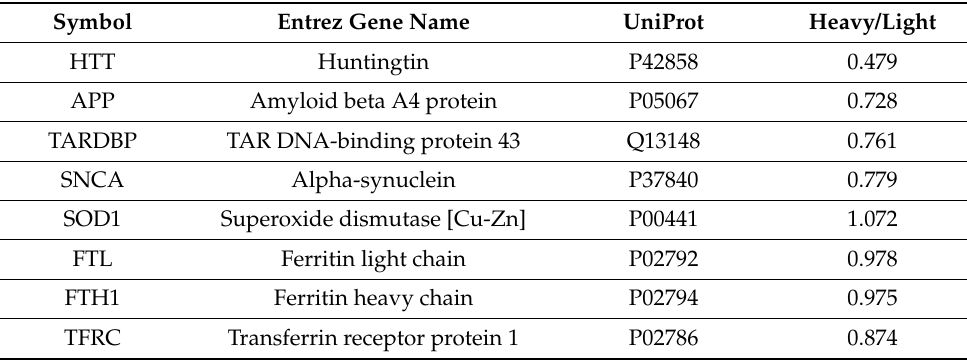
Figure 2. Functional bioinformatic characterization of proteins lowered by Posiphen treatment. ( A , B ) Up-stream regulator analysis by IPA identified APP related proteins. Several APP up-stream regulators were identified by IPA up-stream regulator analysis. Proteins with fold change ≥ 1.5 or ≤ 0.5 are listed in the table ( B ) and schematically represented ( A ). Legend key of IPA prediction is displayed. ( C ) Schematic representation of the interaction network of HTT, APP and α SYN. The central nodes of the networks are highlighted in yellow; the first interacting proteins are linked by the thick dark lines, and the additional interacting proteins within the network are represented by light gray lines. The scale of the protein expression levels is shown in a graded scale from down-regulated ( blue ) to up-regulated ( red ) proteins. The interacting proteins identified have a have a high confidence score (>70%). Table 1. Changes in protein levels of neurotoxic proteins whose mRNAs contain an atypical IRE and control proteins whose mRNAs contain a canonical IRE (FTL, FHL1 and TFRC) in their 5 (cid:48) -UTRs following Posiphen treatment of SH-SY5Y